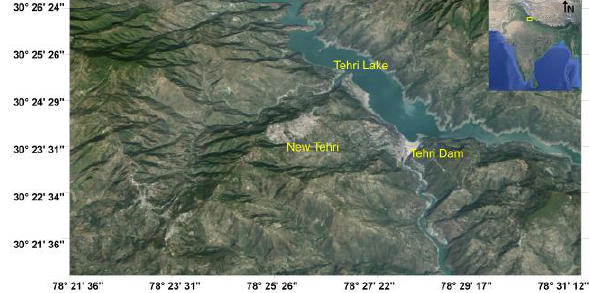
Fig. 1: Study area location (X-axis represent latitude and Y-axis represent longitude)